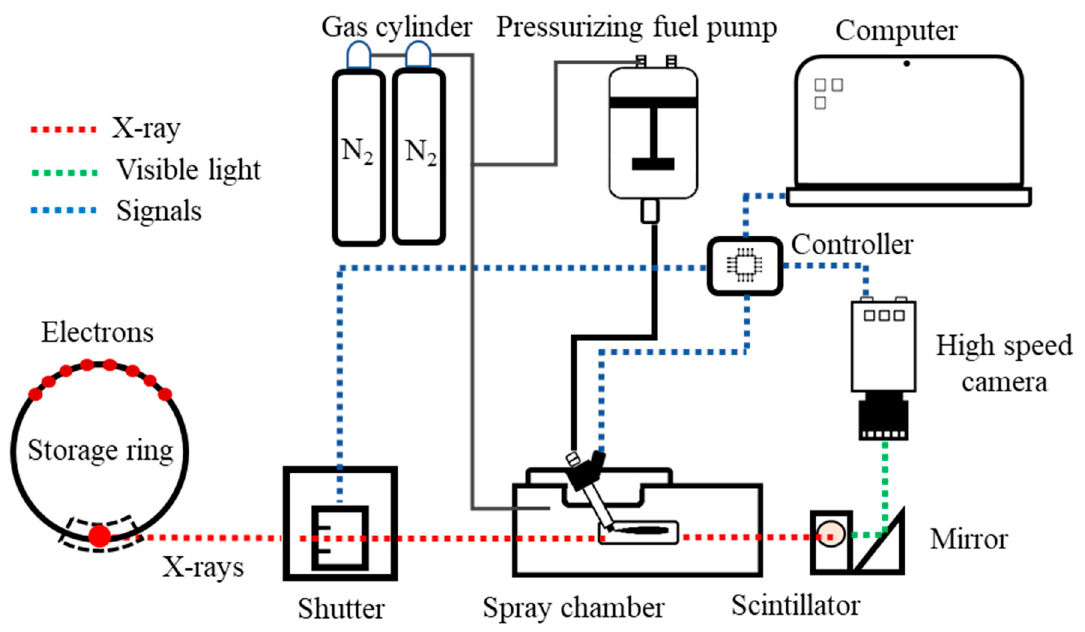
Figure 2. Schematic diagram of XPCI experiment.